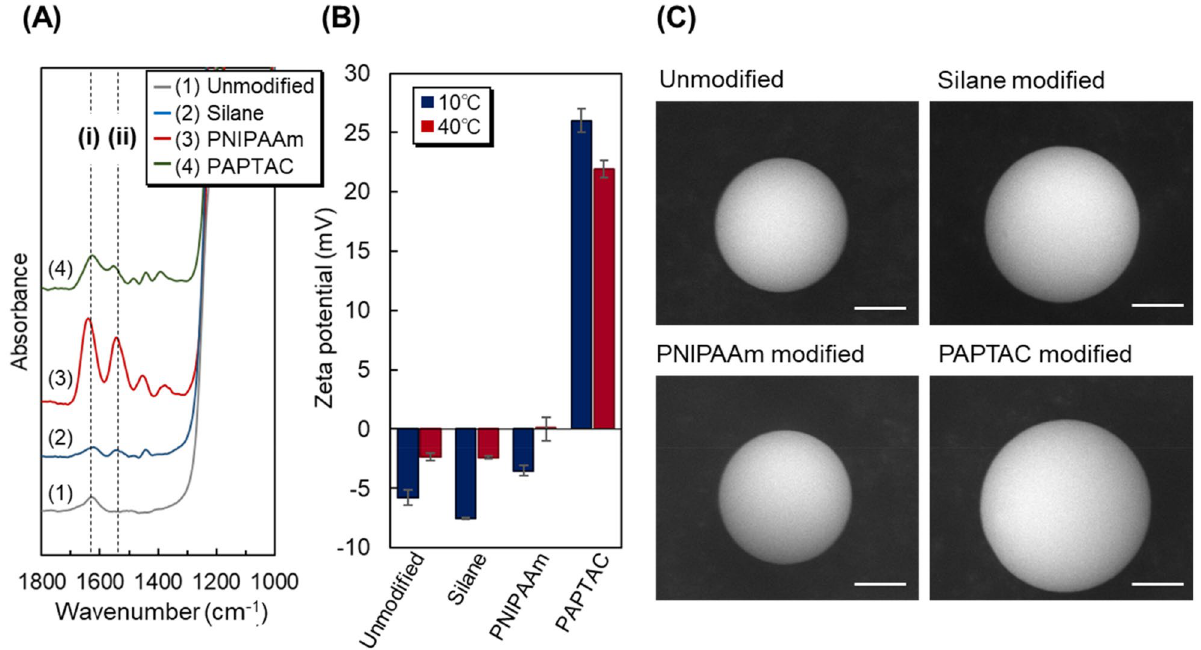
Figure 2. Characterizations of the prepared beads. ( A ) FT–IR spectra of the prepared beads. The dashed lines, (i) and (ii), indicate the peaks attributed to the C=O stretching and N–H bending vibrations, respectively. ( B ) Zeta potential of the prepared silica beads (n = 3). ( C ) SEM images of the prepared beads where the scale bars = 2 μm. (Figures were drawn Microsoft PowerPoint 2019 Version